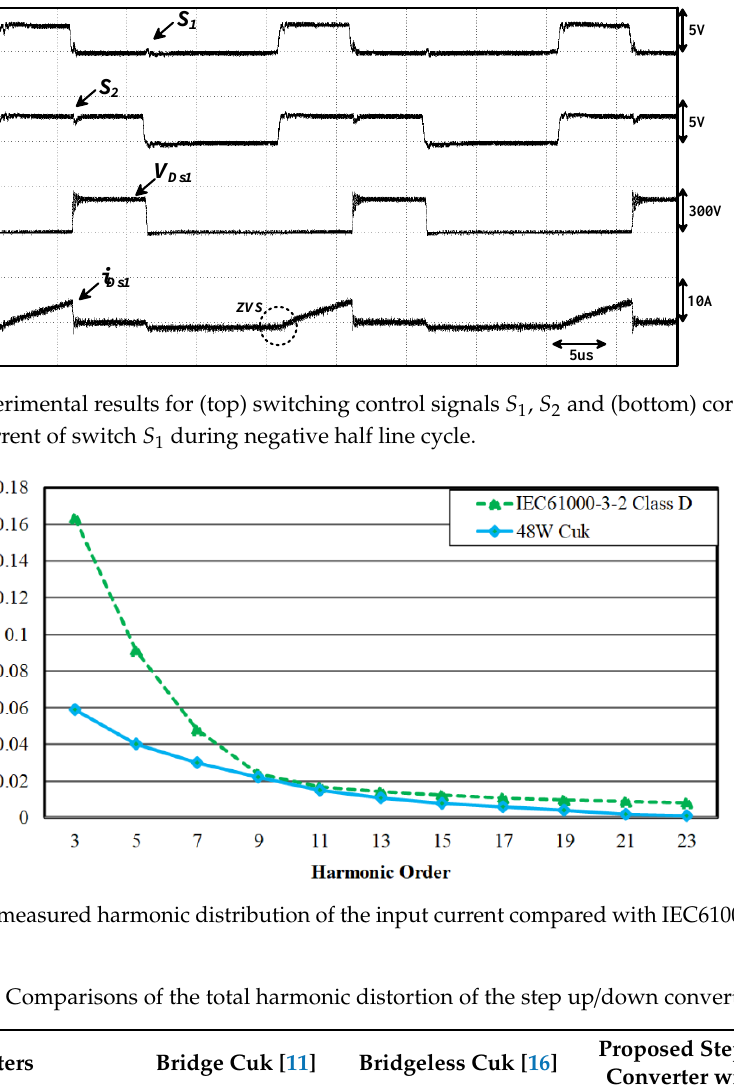
Table 3. Comparisons of the total harmonic distortion of the step up/down converters